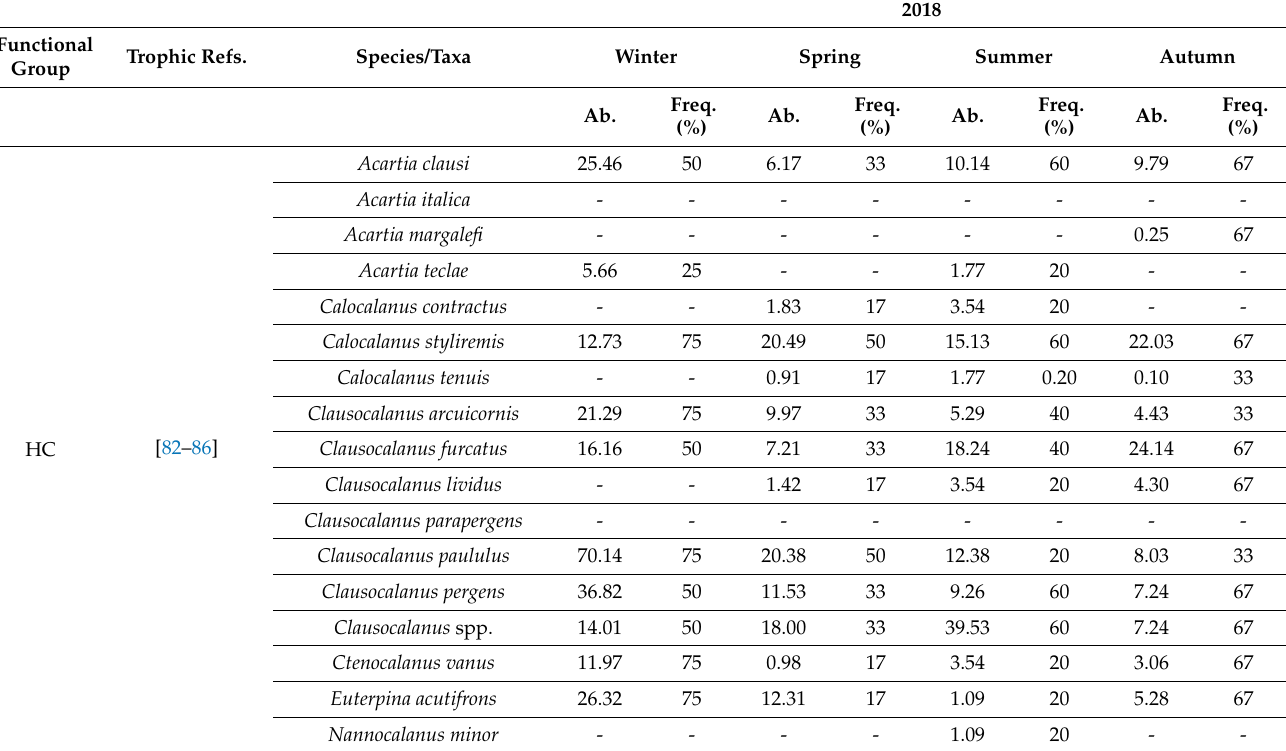
Table A6. Abundance and frequency of species in 2018